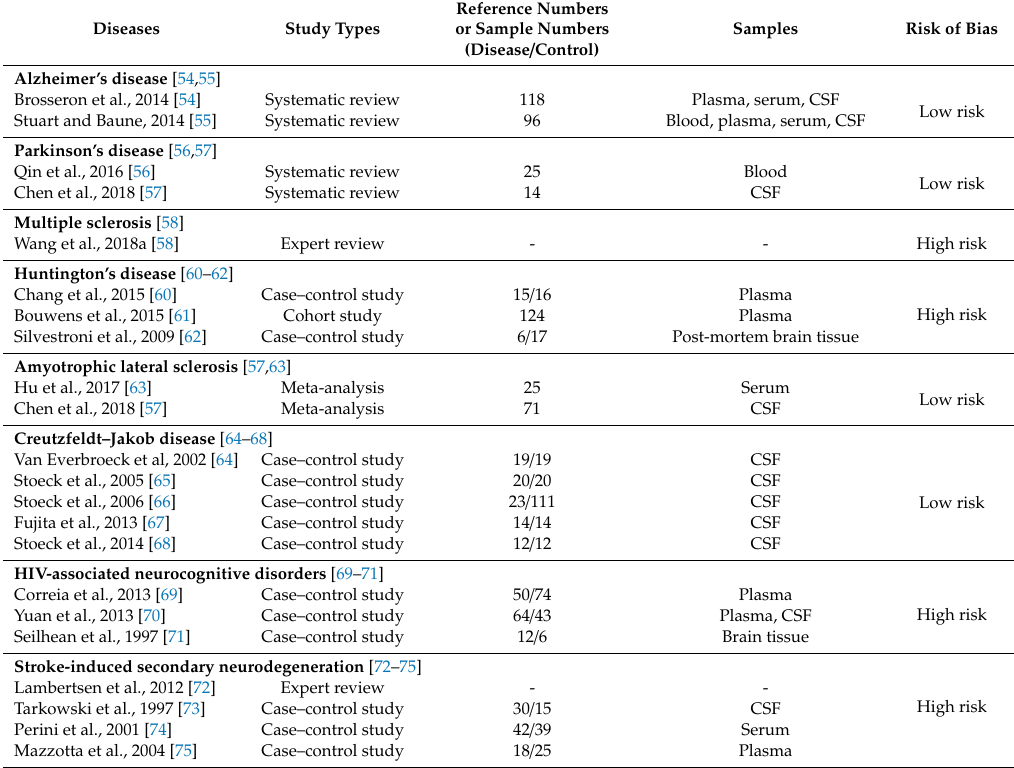
Table A1. Studies of cytokine status included for systematic review synthesis, study designs, and risk bias